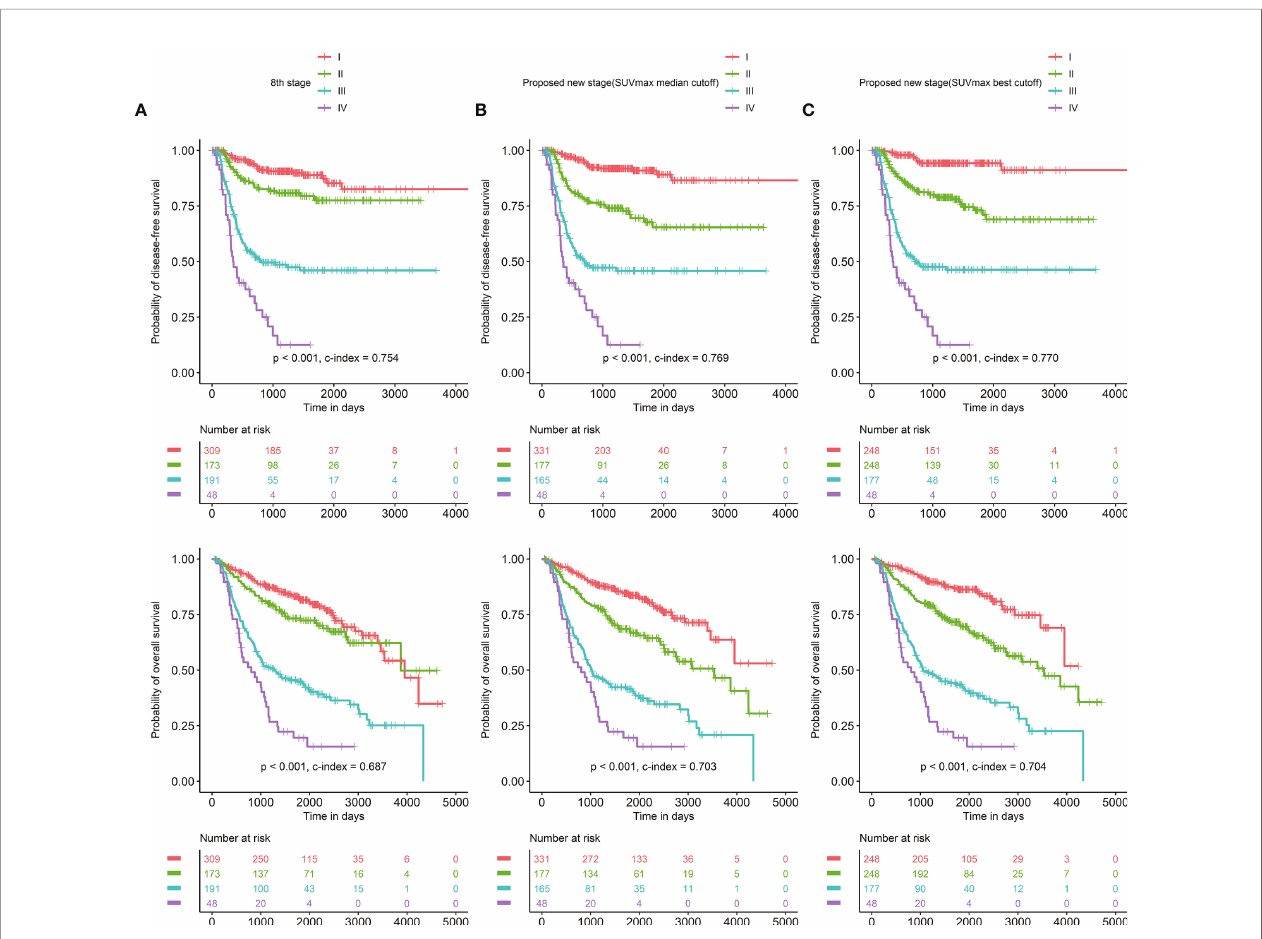
FIGURE 4 | Survival curves according to the conventional stage and the proposed new stage Compared to survival curves based on the 8th-edition pathological stage (A) , those based on our proposed new staging system discriminated prognoses better in reference to both SUVmax with median cutoff (B) and SUVmax with the best cutoff (C)